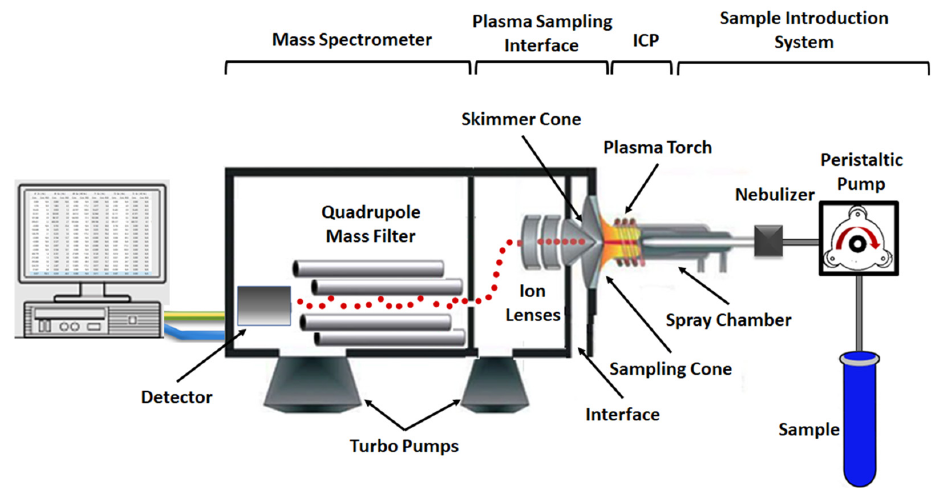
Figure 2. Schematic diagram of the main components of an ICP-MS (Figure adapted with permission and modified from Ref. [21]).